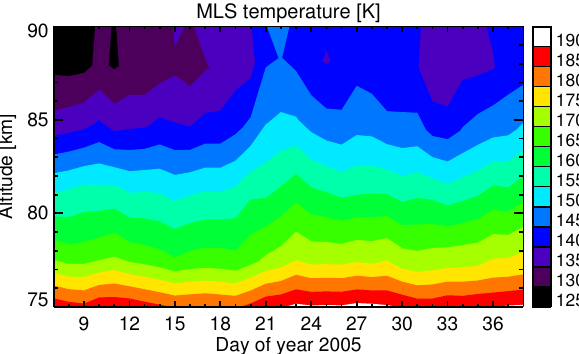
Fig. 3. Zonally averaged daily mean MLS temperature for latitudes 70–80 ◦ S for days 7–38 of year